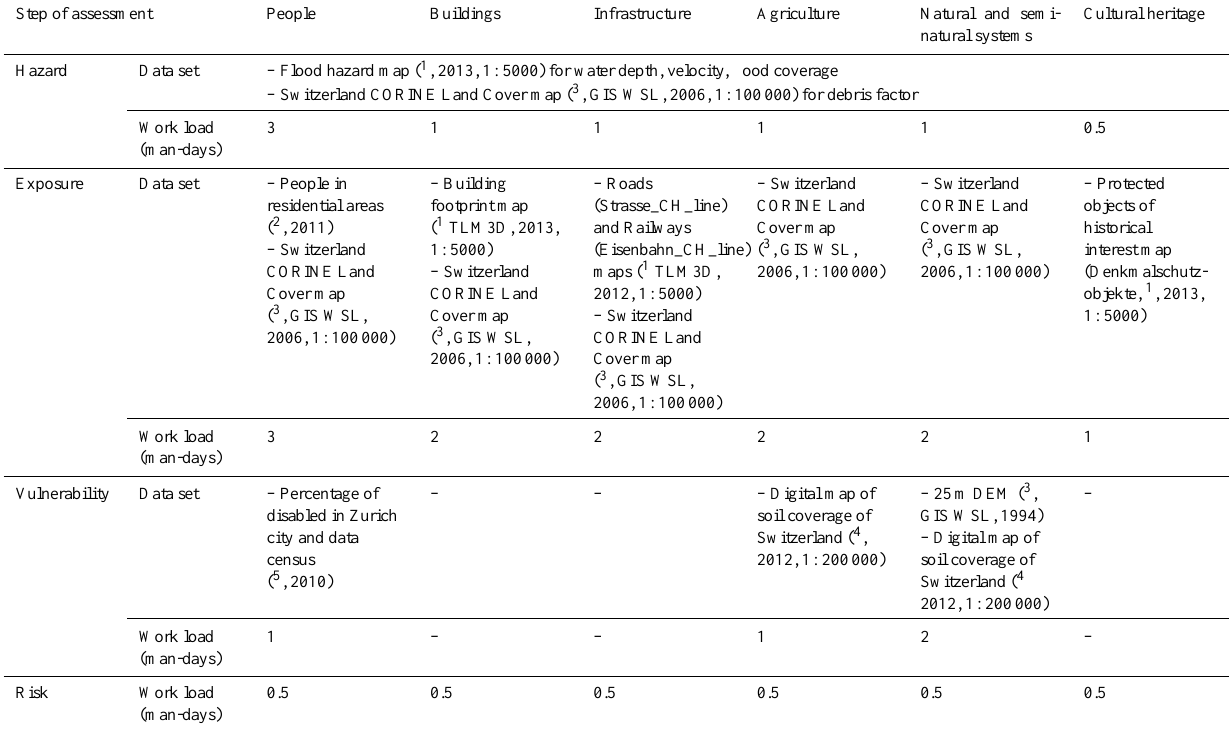
Table 1. Data set used for the application of the KULTURisk RRA methodology within the Sihl River valley. Step of